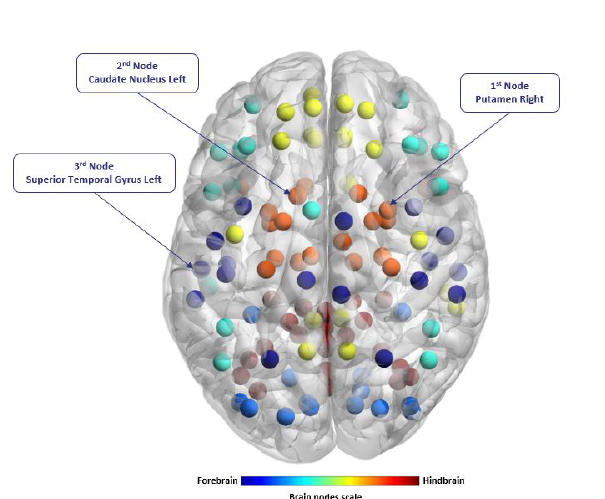
Figure 4. Top-three ranked brain nodes for classification of 3-level ASD subtypes and NC, determined using ANOVA analysis of mean value of